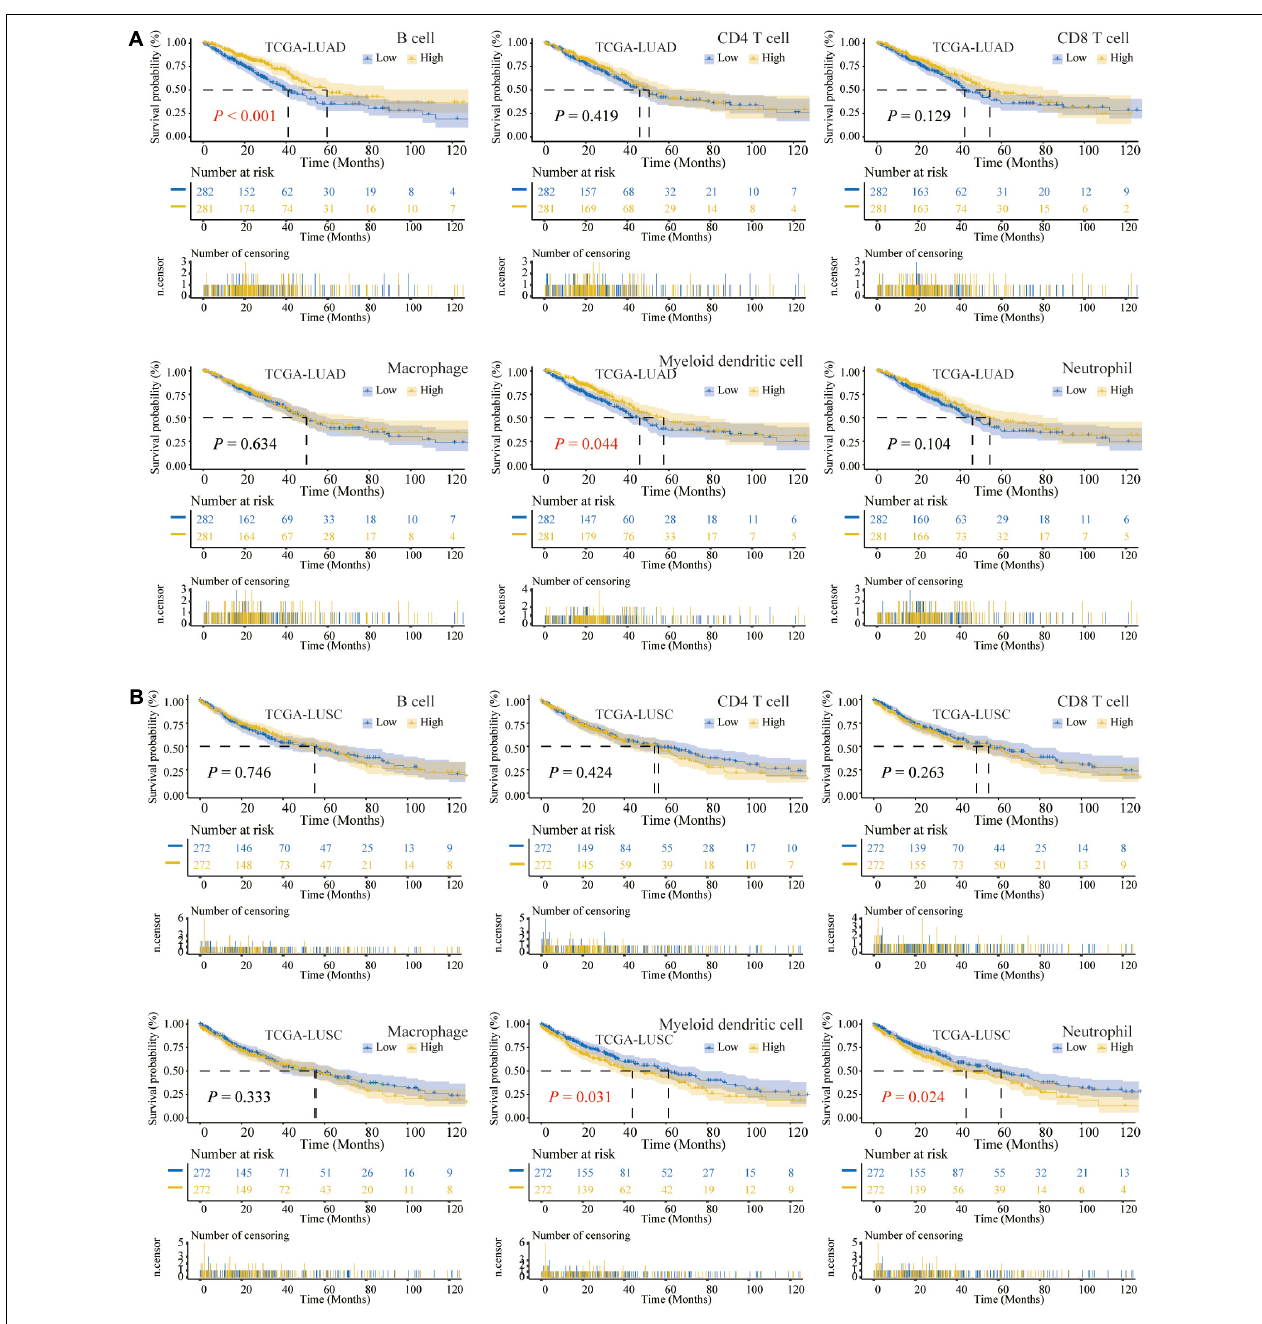
FIGURE 2 | The Kaplan–Meier (K-M) analysis and log-rank test of six types of tumor-infiltrating immune cells (TIICs) in lung cancer. (A) For TCGA-LUAD, the higher the abundance of B cell or DC1, the longer the overall survival (OS). (B) In TCGA-LUSC, the lower the infiltration of DC1 or neutrophil, the longer the OS.